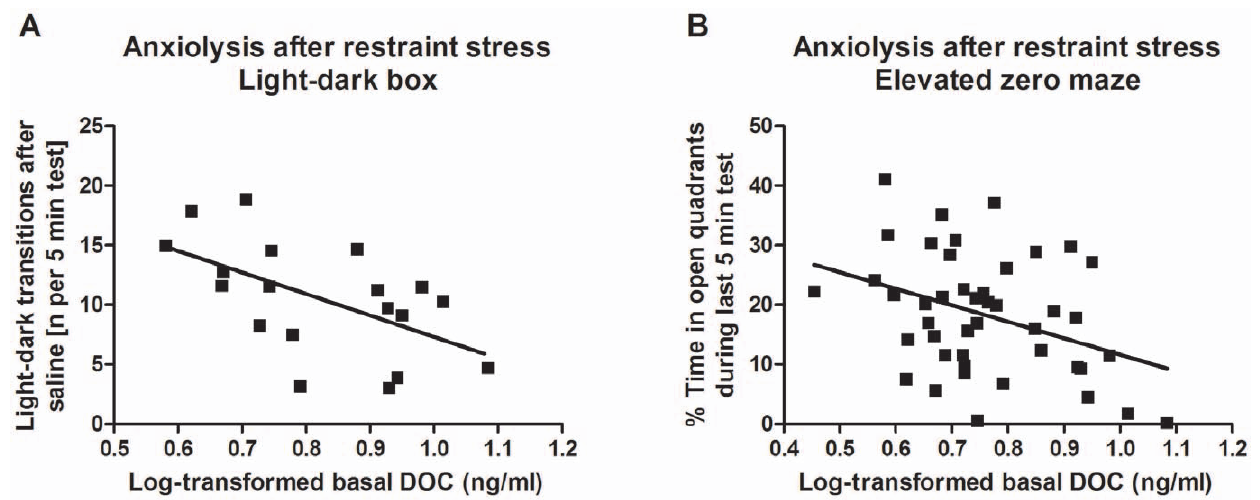
Figure 4. Genetic correlations between basal plasma DOC levels and phenotypes for anxiety-like behavior previously characterized in the BXD strains. Data for anxiety-like behavior has been collected by two independent labs and has been obtained from GeneNetwork (www. genenetwork.org). A) Pearson’s r = 2 0.56, p =0.011, Spearman’s r = 2 0.63, p =0.003, n =19; Putman & Miles, manuscript submitted, GN ID 10960. B) Pearson’s r = 2 0.37, p =0.012, Spearman’s r = 2 0.34, p =0.022, n =44; Cook et al. , unpublished, GN ID